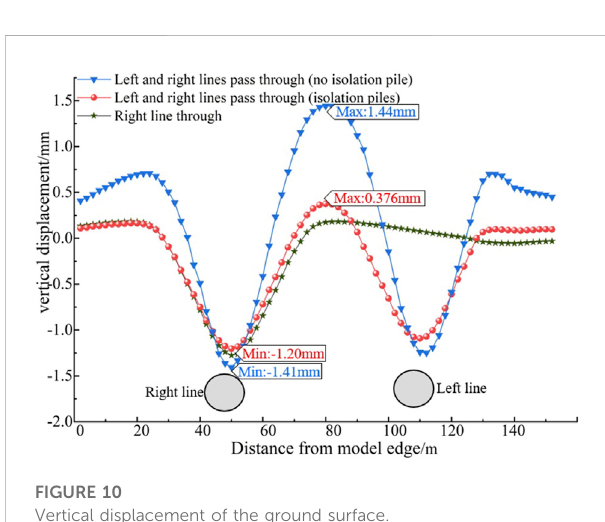
FIGURE 11 Comparison contour maps of the total displacement impact